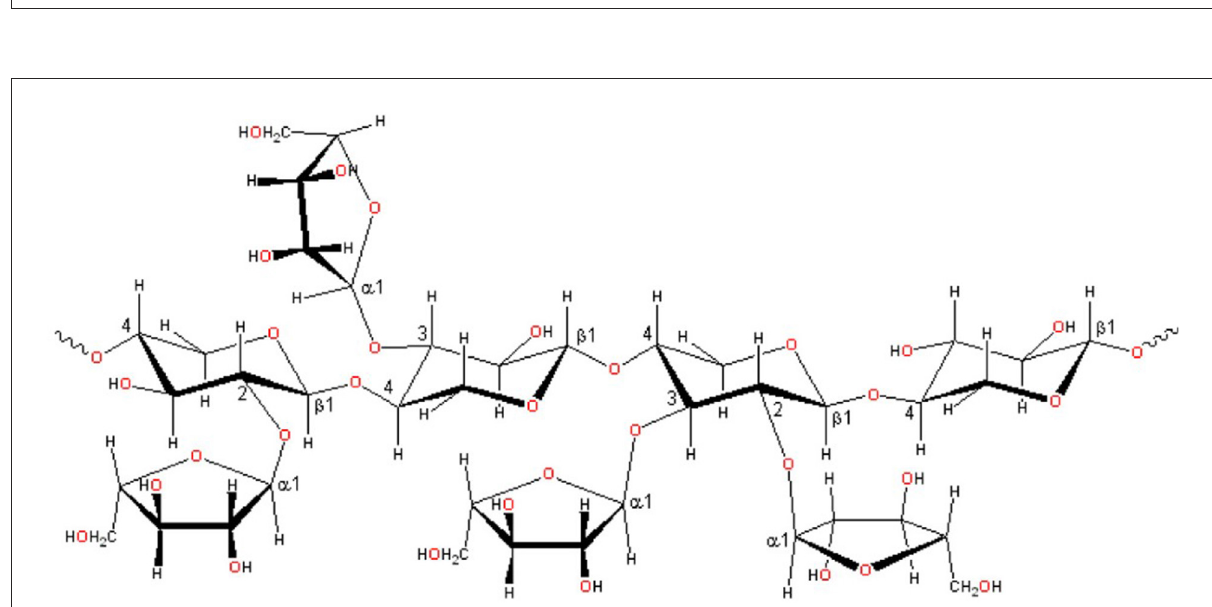
FIGURE2 Xylan structure shows different intermolecular bonds [Adopted from Otieno et al.